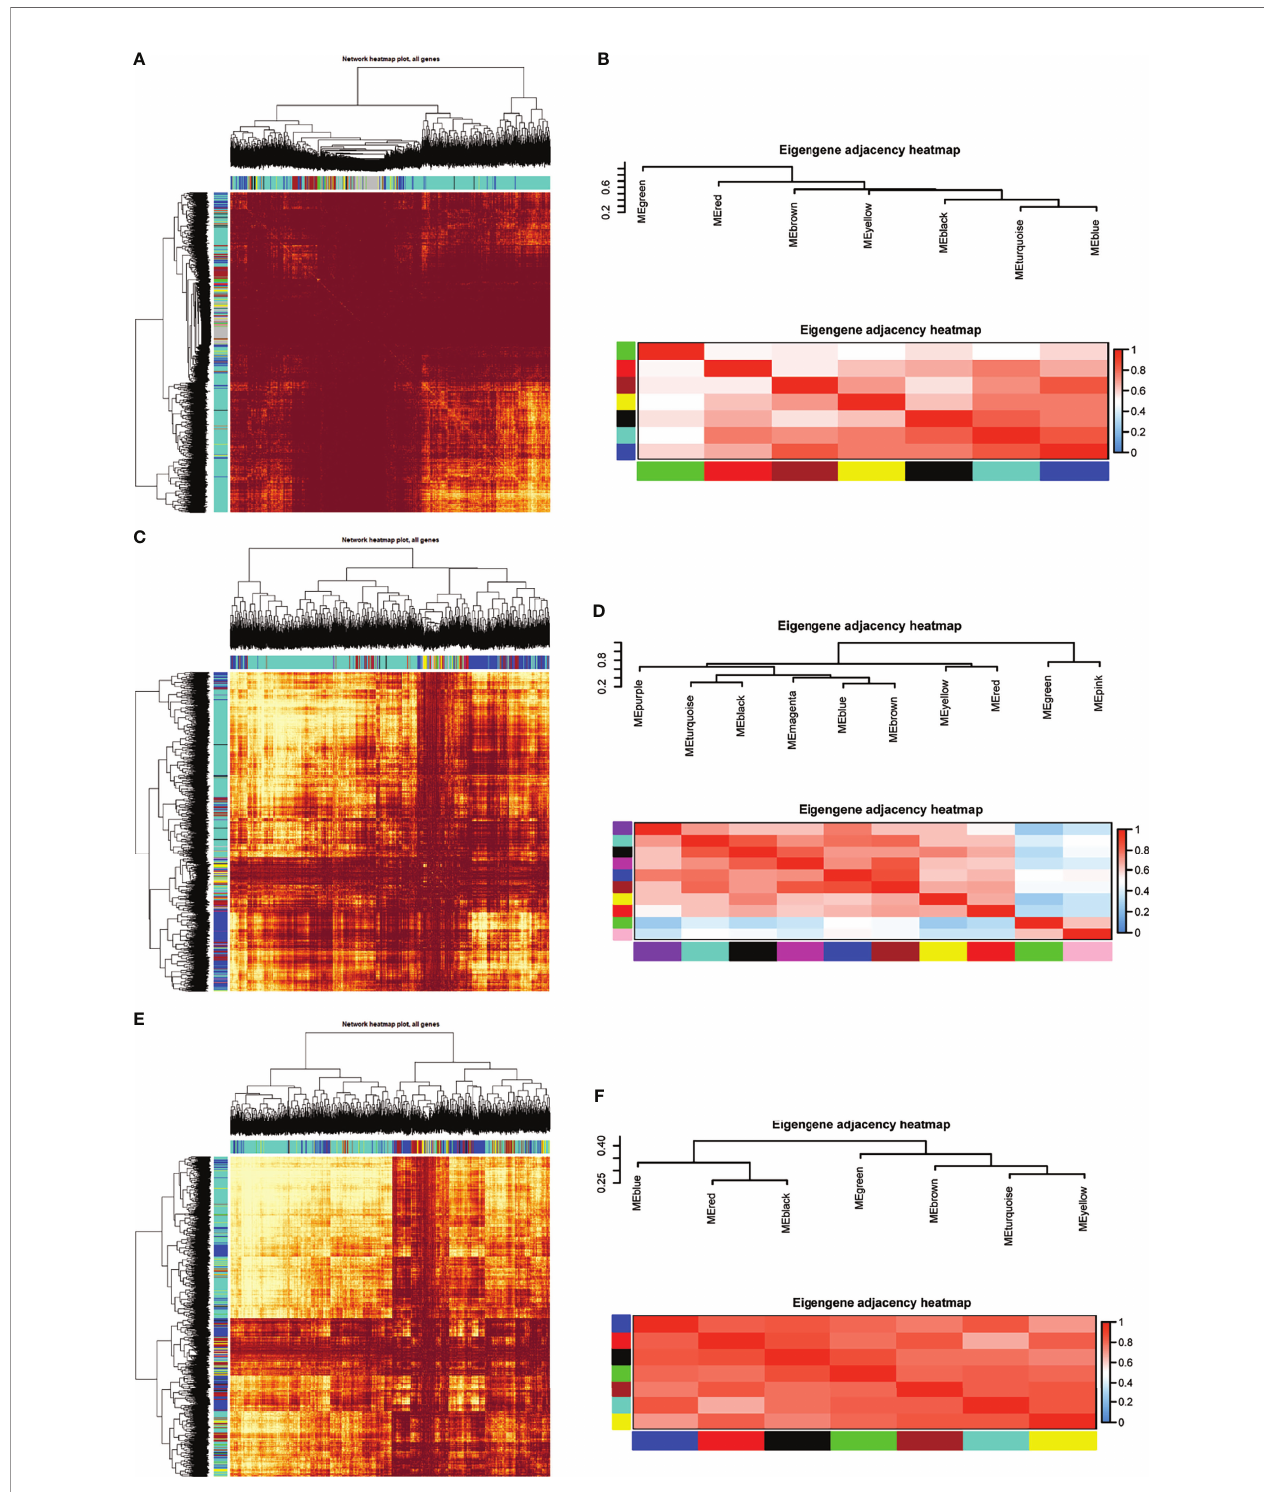
FIGURE 2 | Module preservation analysis. Visualization of the WGCNA network using a heatmap plot in (A) T2DM versus normal controls, (C) T2DM versus prediabetes and (E) prediabetes versus normal controls (The heatmap depicts the topological overlap matrix (TOM) among all genes included in the analysis). (B, D, F) represented the heatmap plot of the adjacencies of modules in T2DM versus normal controls, T2DM versus prediabetes and prediabetes versus normal controls,